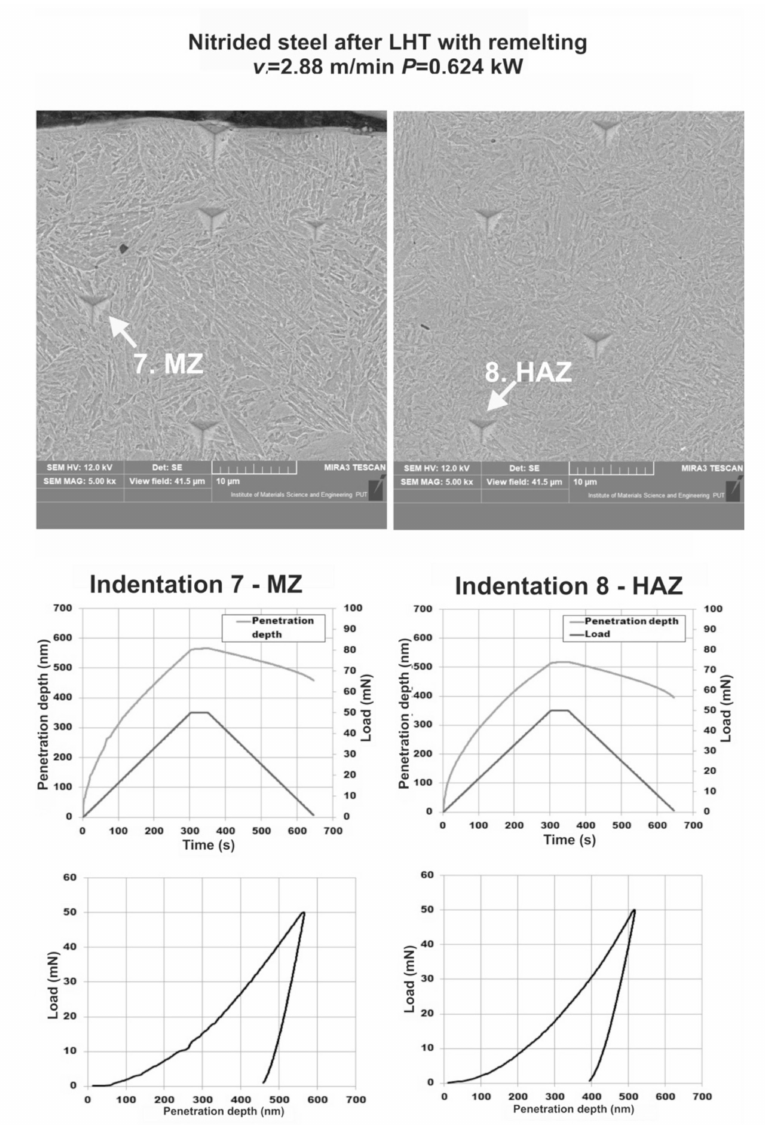
Figure 14. SEM images of indentations and the corresponding curves after gas-nitriding and LHT with remelting ( P = 0.624 kW and v l = 2.88 m · min − 1 ): re-melted zone (MZ)—indentation 7, heat-a ff ected zone (HAZ)—indentation